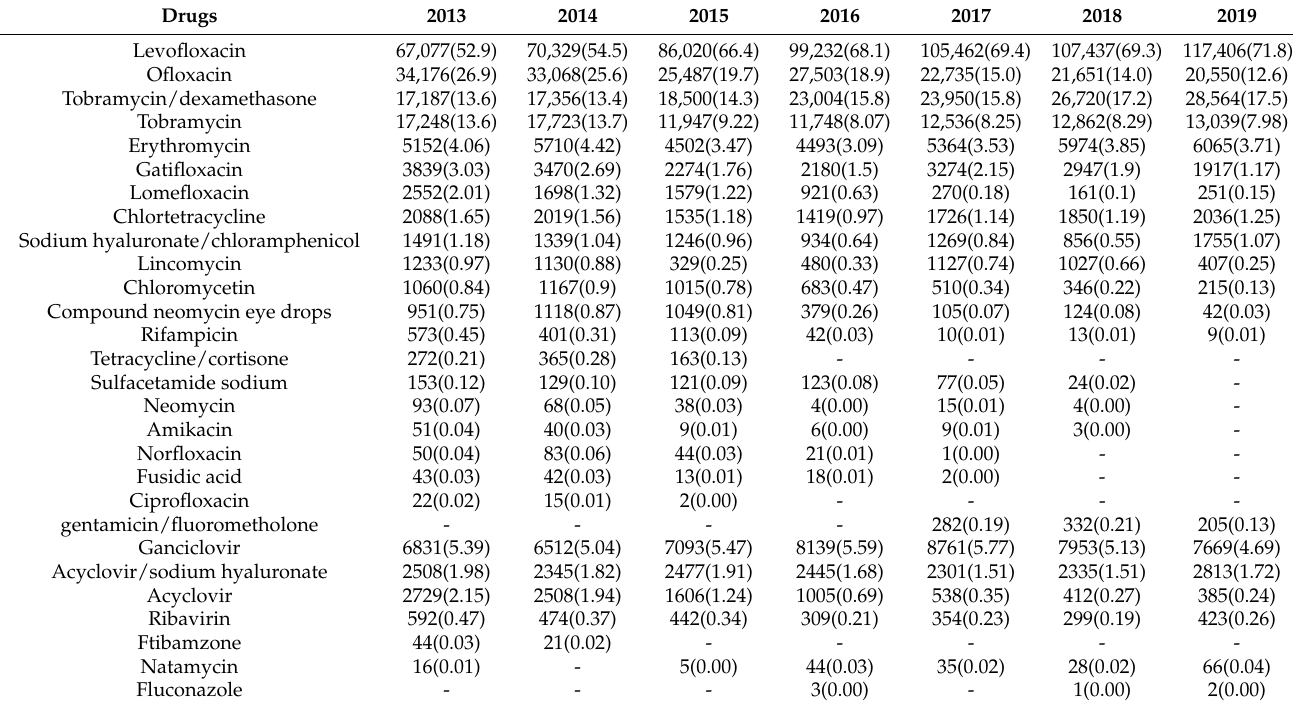
Table 2. Numbers of ocular topical anti-infectives prescriptions from 2013 to 2019 1 .